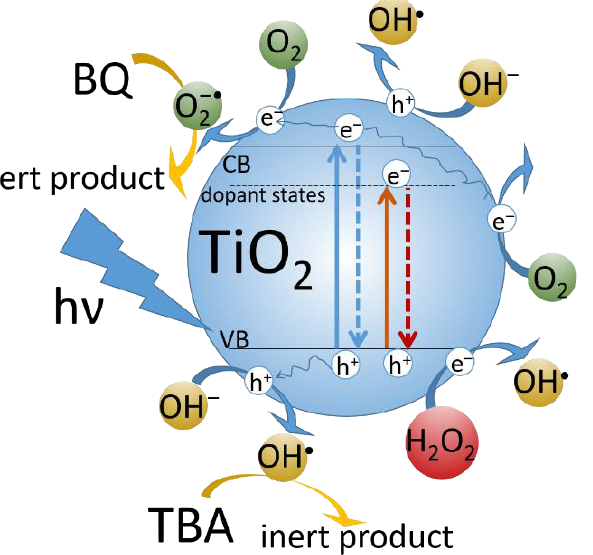
Figure 1. A schematic illustration of the photophysical processes in photocatalysts. BQ and TBA stand for benzoquinone and tert-butyl alcohol.